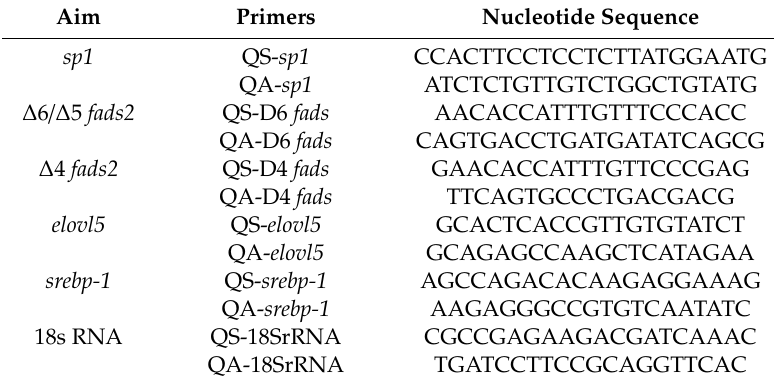
Table 8. Primers used for